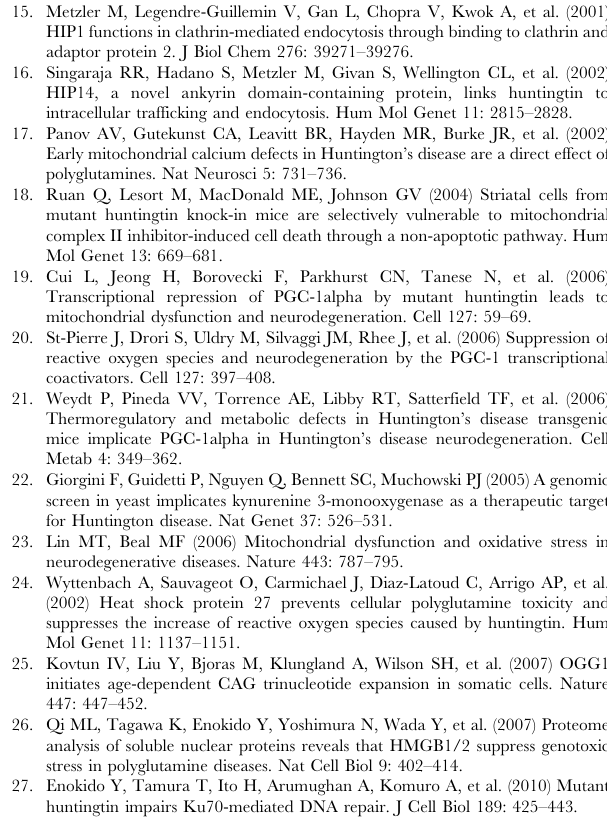
Figure S4 Ku70 elongates the lifespan of an indepen- dent line of Htt103Q-expressing flies. To exclude the insertion effect of the Ku70 transgene, we tested another transgenic line generated by independent injection of the UAS- Ku70 vector. Consistently with the result in Figure 3C, we observed that Ku70 rescued the lifespan shortening by Htt103Q. Figure S5 Knock down of Drosophila Ku70 accelerates locomotion disability of mutant Htt transgenic flies. Startle-induced negative geotactic response was used to assess locomotion ability of flies, and time to reach to 5 cm high was counted. To test the effect of DmKu70 knock down on mutant Htt expressing flies, we compared the time between Htt103Q transgenic flies and DmKu70-KD/Htt103Q transgenic flies at 3, 7 and 14 days after eclosion. We found acceleration of locomotion disability by DmKu70-KD in female flies. We employed ANOVA and posthoc Dunnett’s test to compare them. *p ,